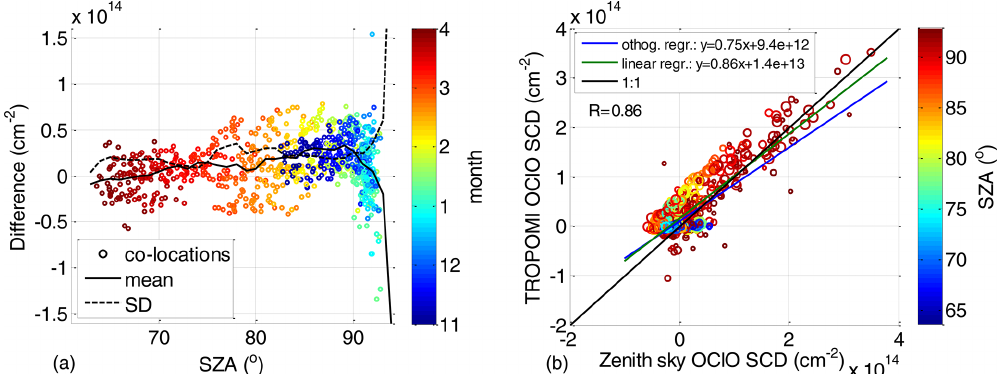
Figure C3. Same as Fig. 6 but comparison with ground-based OClO SCDs at Kiruna retrieved with Ring spectra at a single temperature and without the OClO × λ term in the DOAS